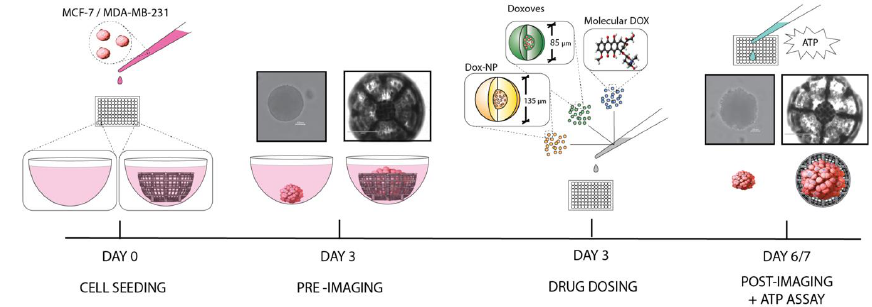
Figure 2. Schematic representation of experimental process.